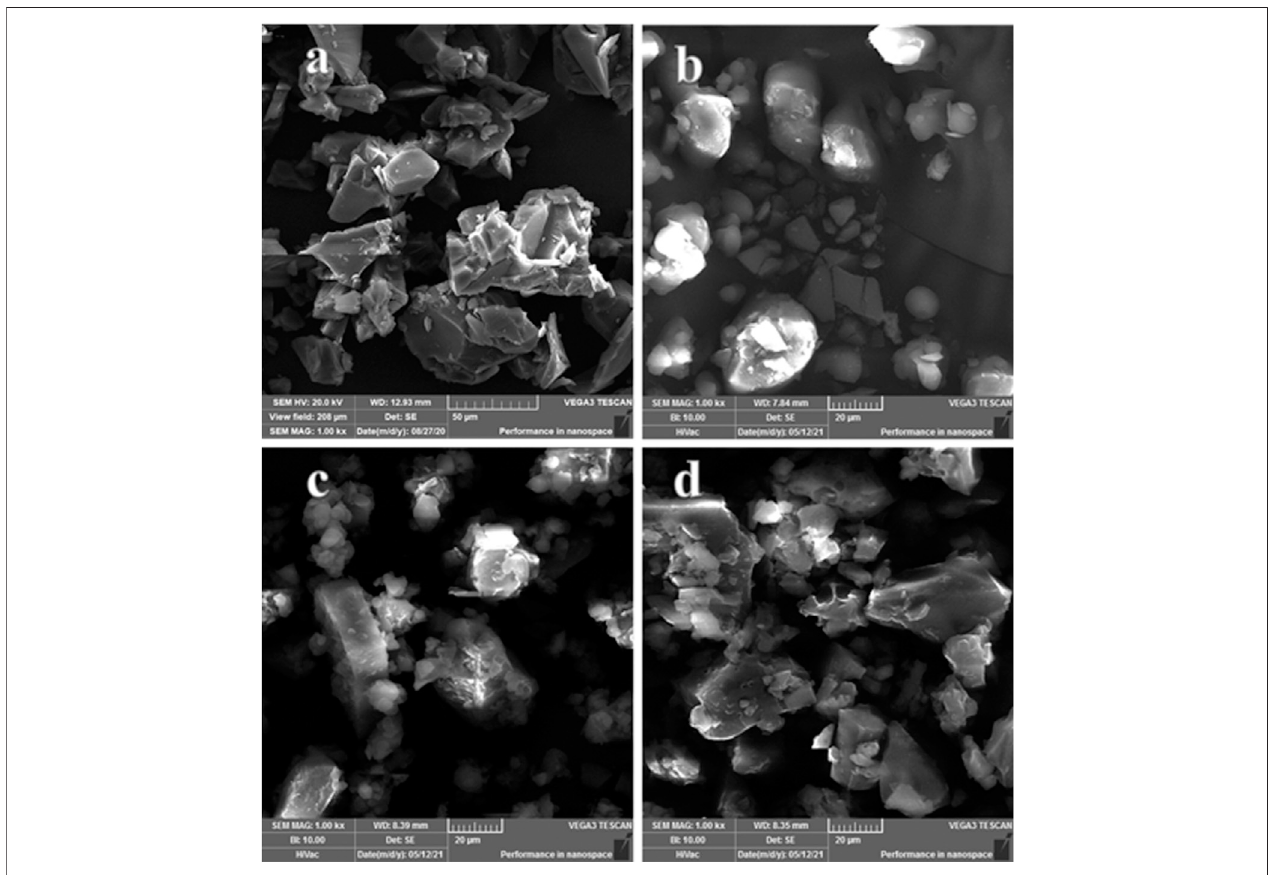
FIGURE 3 | SEM microphotographs: (A) BIO-CD; (B) AD-CBD; (C) the physical mixture (AD-CBD: BIO-CD (cid:1) 1:1), and (D) AD-CBD/BIO-CD inclusion complex.